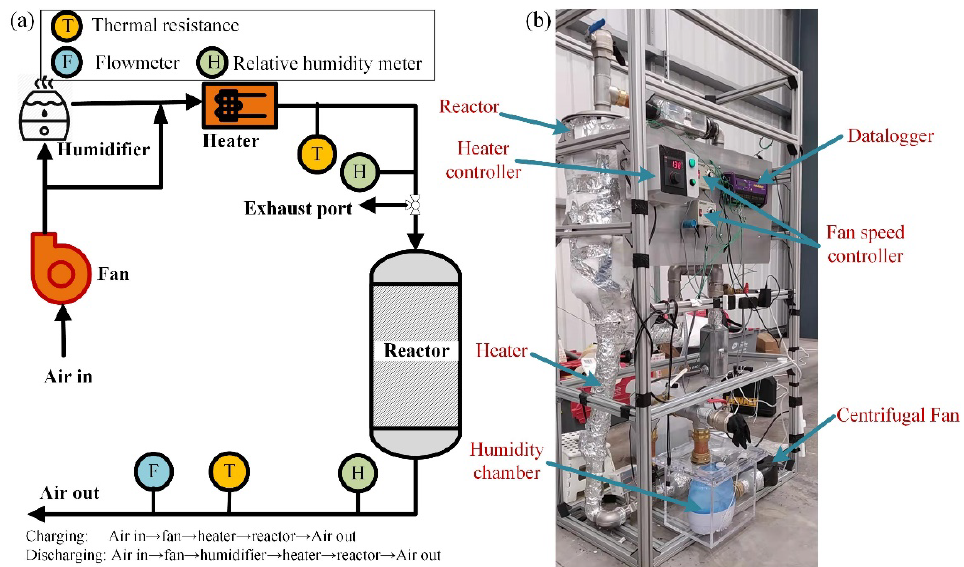
Figure 2. ( a ) The flow chart and ( b ) an image of the physical system.